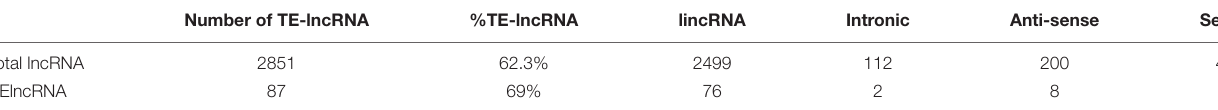
TABLE 2 | Summary of TE-lncRNAs.